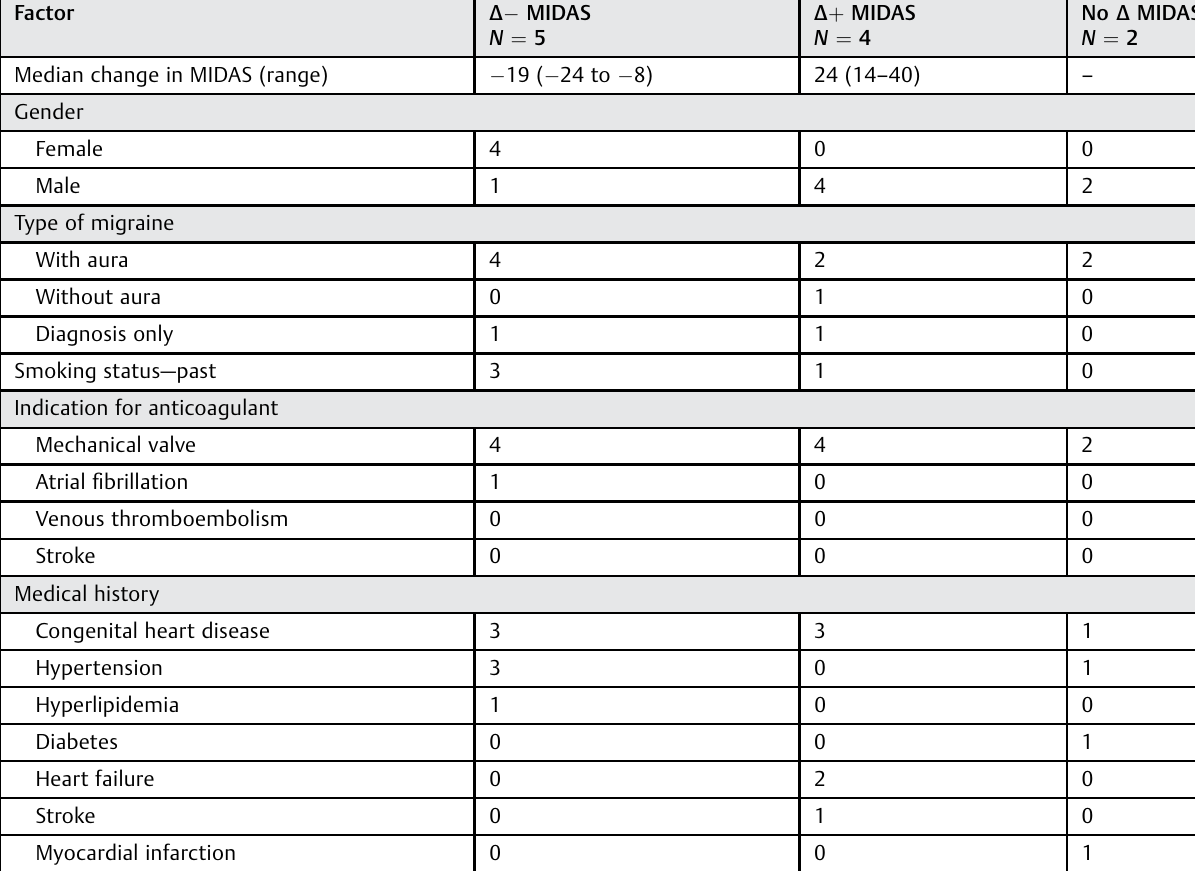
Table 2 Characterization based on change in